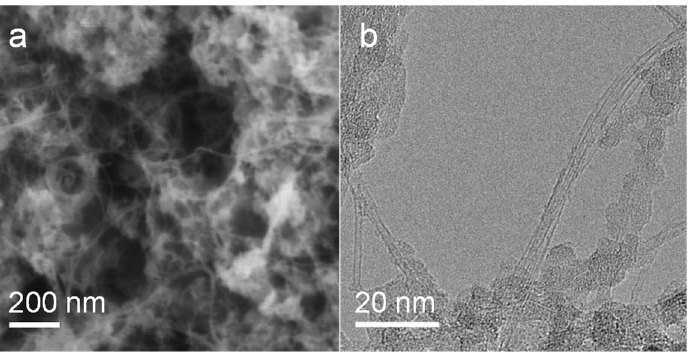
Figure 4. ( a ) SEM image and ( b ) TEM image of SWNTs grown from Pd@MgO catalyst at 900 °C.